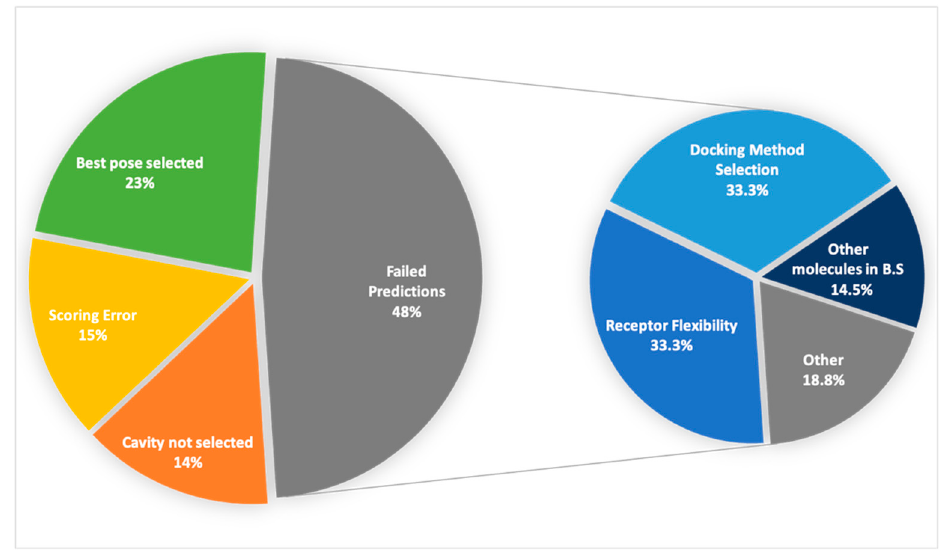
Figure 5. Overall view of validation set cases.